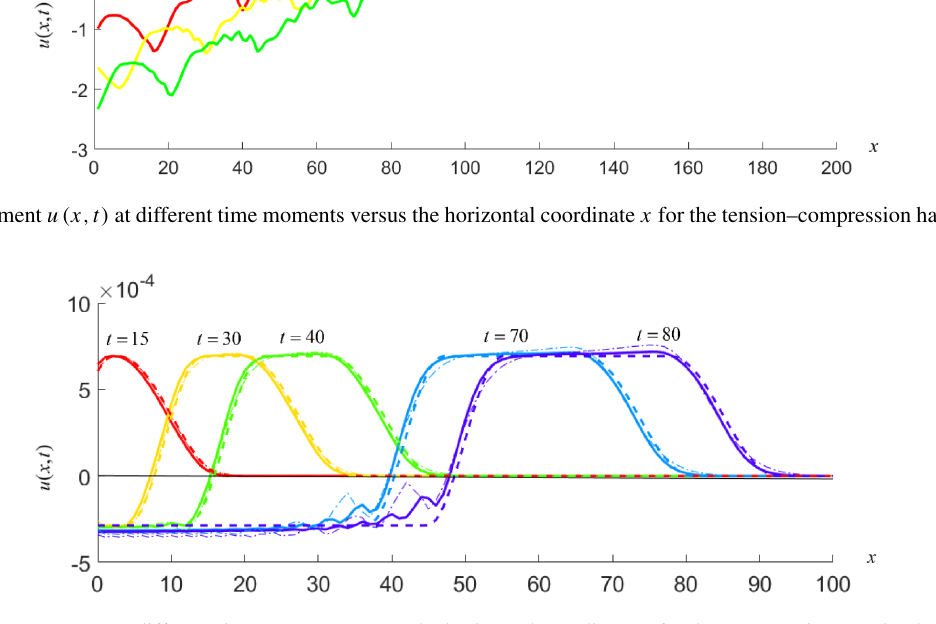
Figure 7. Displacement u(x,t) at different time moments versus the horizontal coordinate x for the compression–tension harmonic impulse: analytical solution (dashed line), numerical solutions for the discrete chain (solid line), and the bimodular rod (thin dash-dot